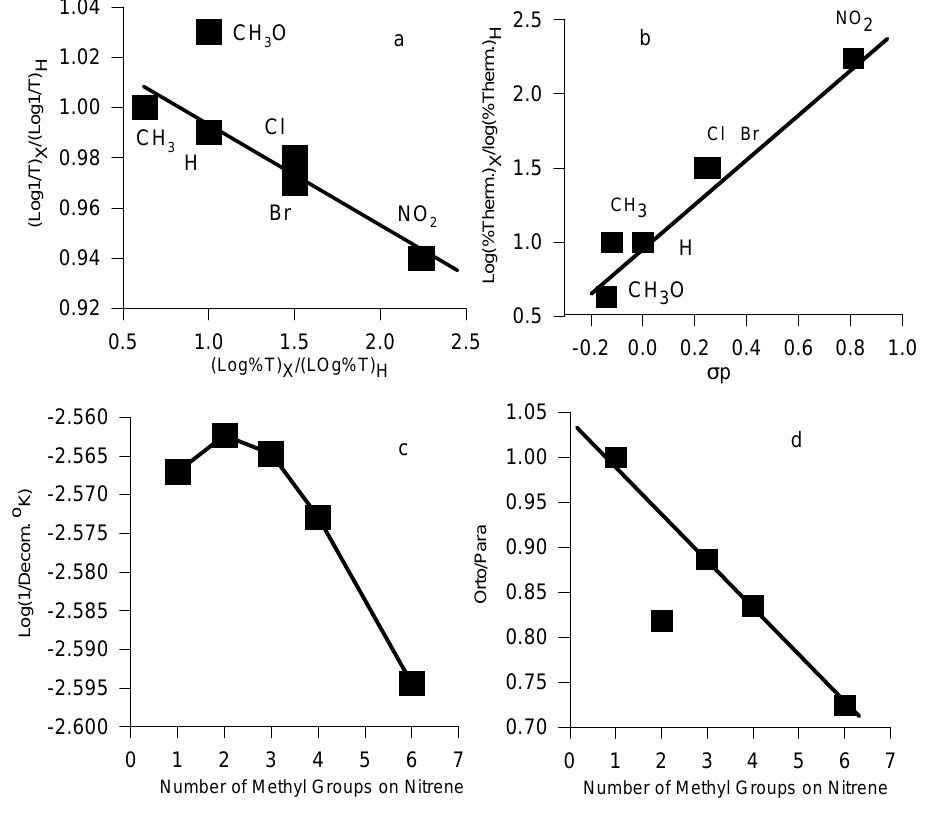
Figure 1: a) Correlation of the thermal decomposition (1/T phase with % Thermolyzate (%T) of imidoyl azides in anisole. b) Typical Hammett plot for the relative % Thermolyzate (%Therm.) of (substituted azides) c) Effect of the number of methyl groups on azide on the thermal decomposition (T anisole. d) Effect of the number of methyl groups on nitrene (Y and Z) on the ortho-para ratio for the thermal decomposition of imidoyl azides in